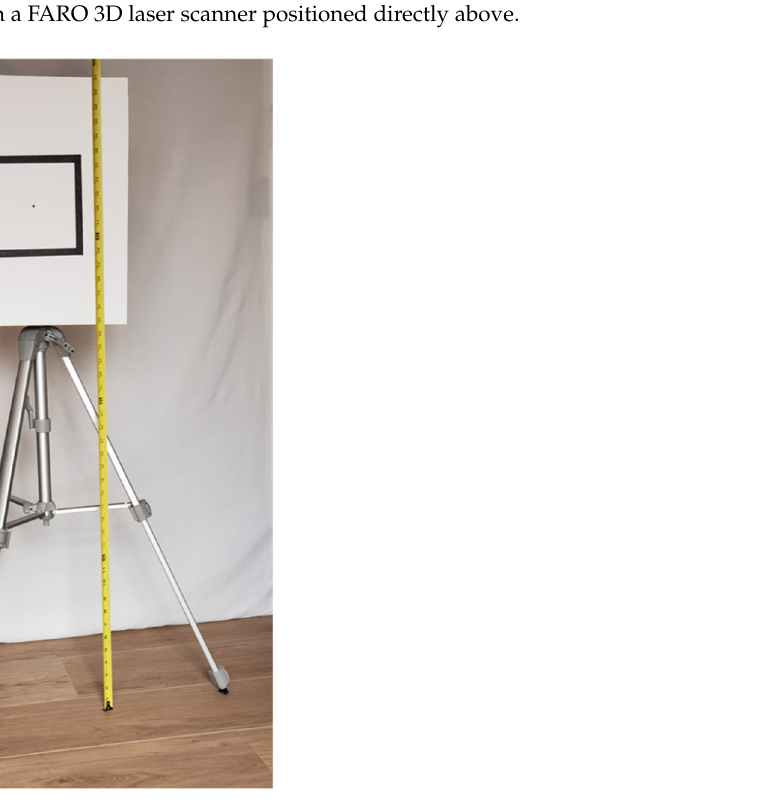
Figure 2. A planar board marked with a rectangle and a point is used as the test object for scanning. In a manner similar to that followed in the study by Yang et al. [7], the object was placed at several locations in the field of view to assess the accuracy of the depth acquisi- tion by the two sensors. The floor in front of the cameras was partitioned into a grid as